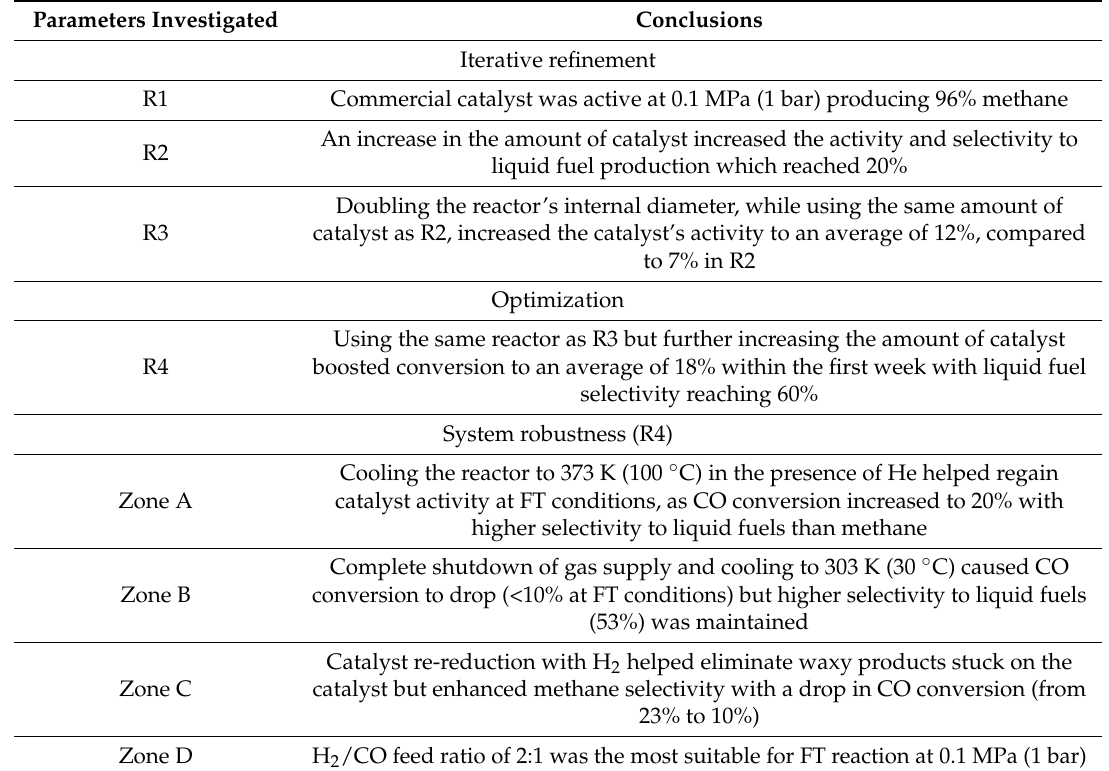
Table 8. Summary of overall